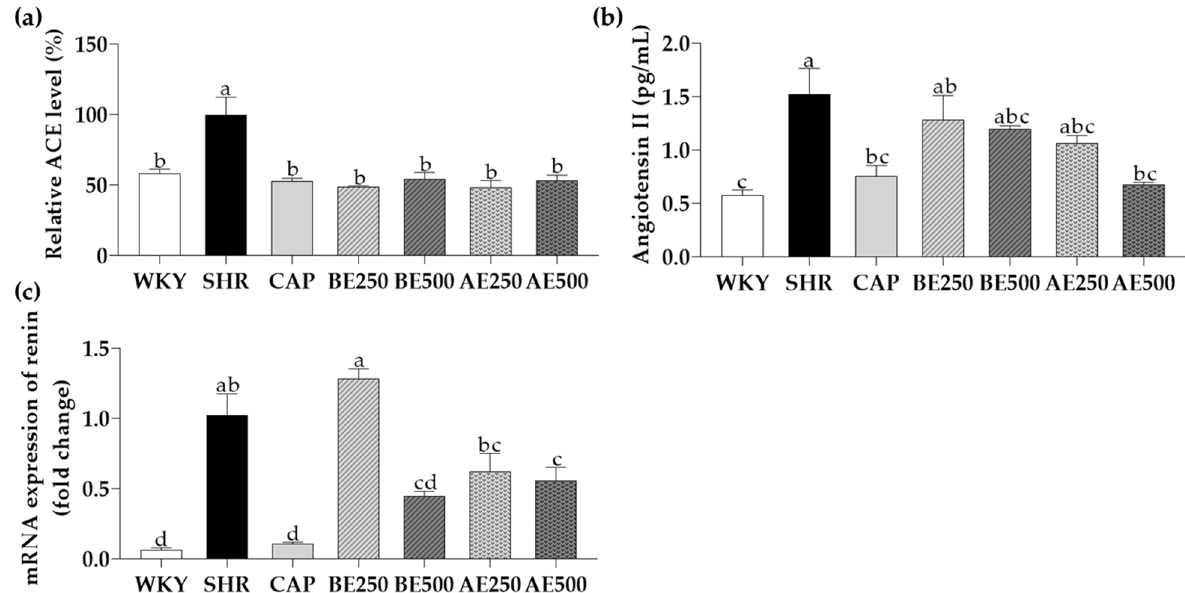
Figure 2. Effects of black soybean or adzuki bean extracts on ( a ) relative angiotensin converting enzyme (ACE) level (%), ( b ) angiotensin II level in serum, and ( c ) renin mRNA expression in renal tissue of the rats administered with black soybean or adzuki bean extracts for 8 weeks. Data are expressed as mean ± SEM. The values with different letters indicate significant differences at p < 0.05. WKY: Wistar-Kyoto rats, SHR: Spontaneously hypertensive rats, CAP: 50 mg/kg body weight (bw) of captopril, BE250: 250 mg/kg bw of black soybean extracts, BE500: 500 mg/kg bw of black soybean extracts, AE250: 250 mg/kg bw of adzuki bean extracts, AE500: 500 mg/kg bw of adzuki bean extracts.